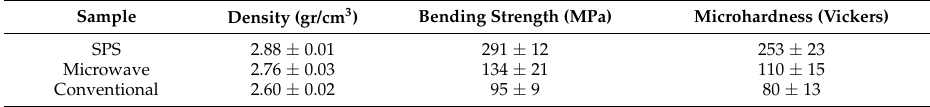
Table 1. Physical and mechanical properties of SPS, microwave, and conventional sintered samples.